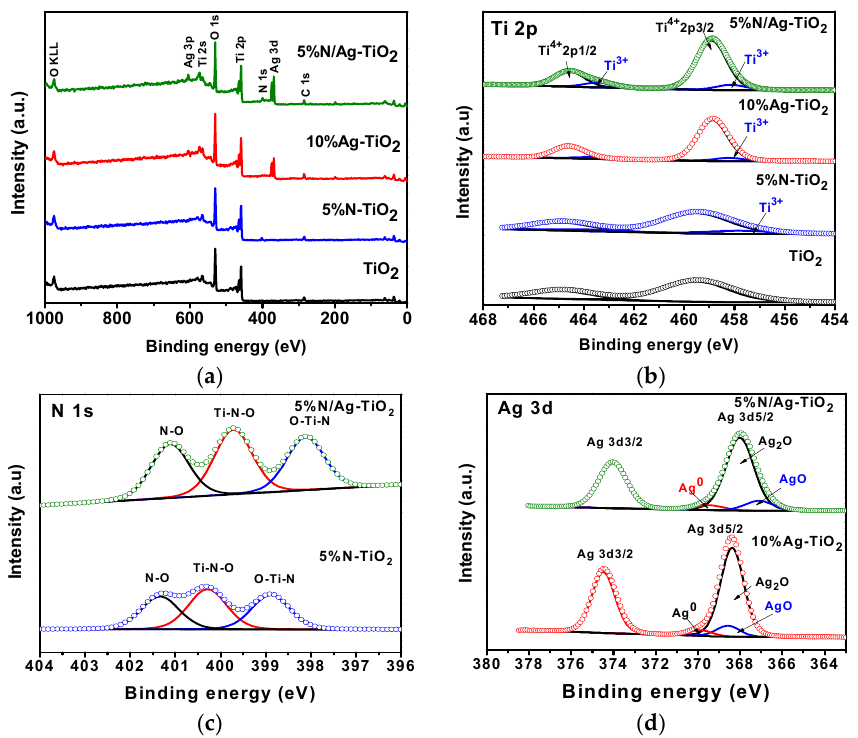
Figure 4. ( a ) Survey scan and high-resolution scan XPS spectra of the photocatalyst for ( b ) Ti 2p, ( c ) N 1s, and ( d ) Ag 3d.